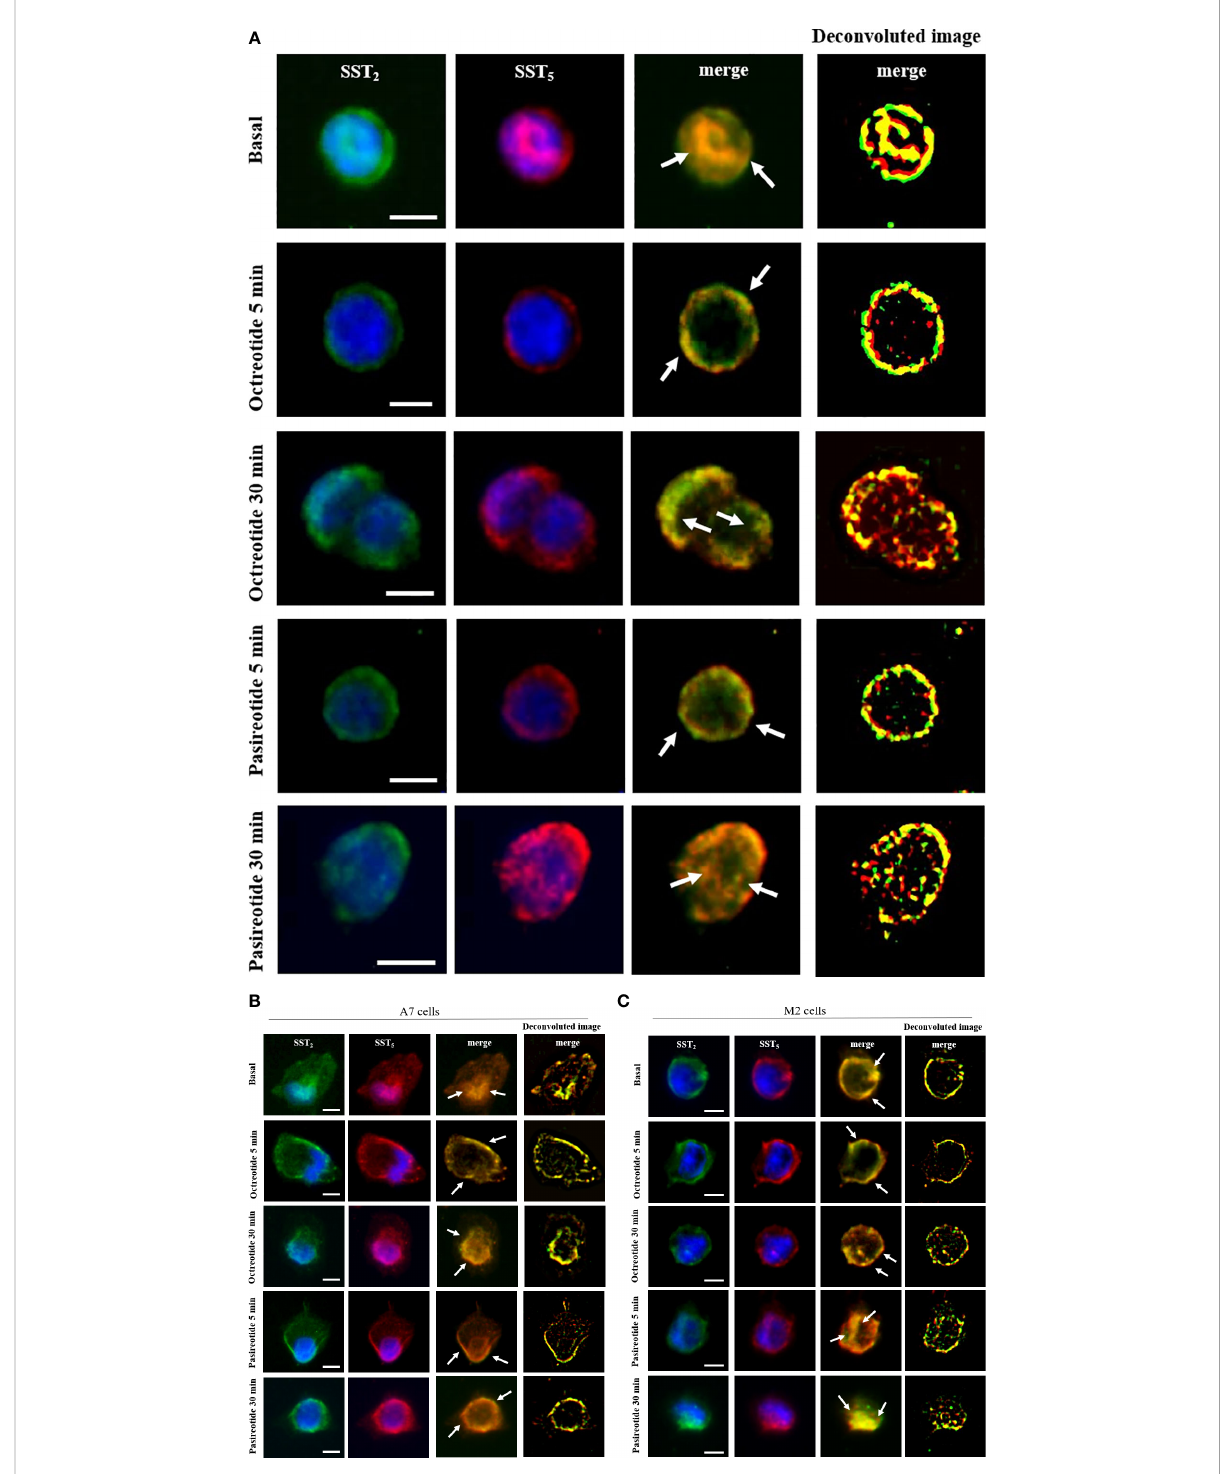
FIGURE 3 SST2 and SST5 intracellular traf fi cking. Representative immuno fl uorescence experiment showing subcellular localization of SST 2 (green) and SST 5 (red) in GH3 cells (A) , A7 cells (B) , and M2 cells (C) stimulated or not with 100 nM octreotide or pasireotide for the indicated times. Nuclei are stained with DAPI in blue. Overlay of green and red channels is shown, and white arrows indicate SST 2 and SST 5 subcellular colocalization. Deconvolution algorithm was applied to further show SST 2 and SST 5 colocalization areas (yellow signals, right columns). Scale bars: 10 m